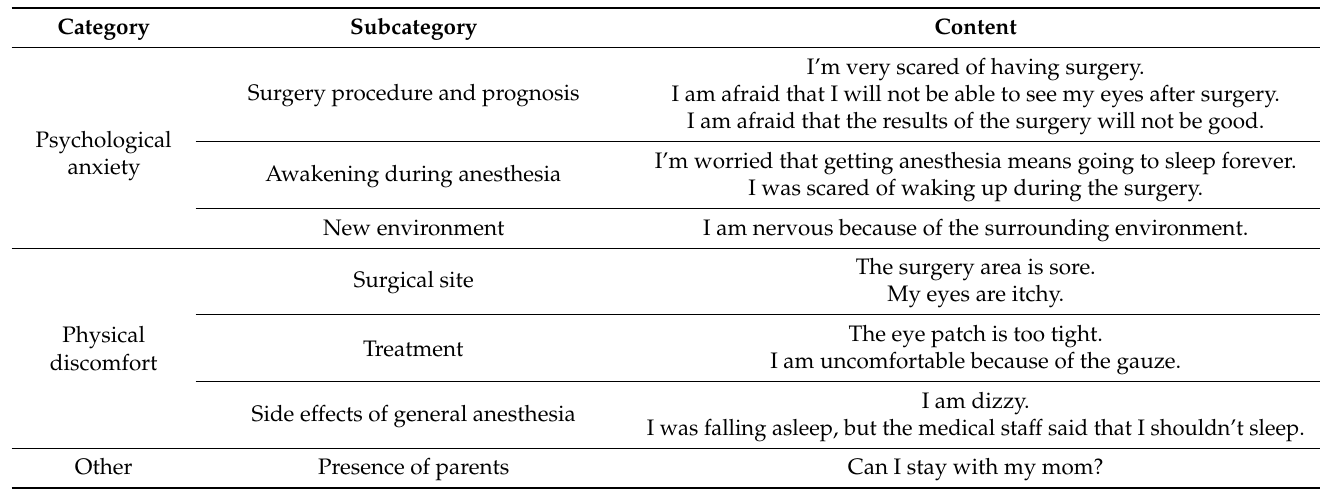
Table 1. Interview of educational